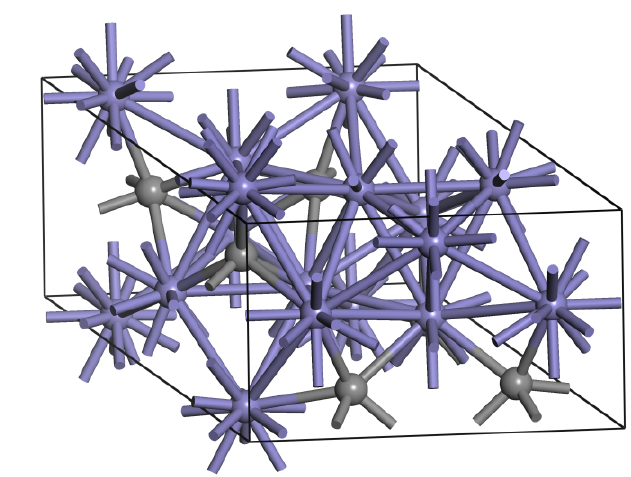
Figure 1. h-Fe 7 C 3 structure (Fe is in blue and C is in gray).